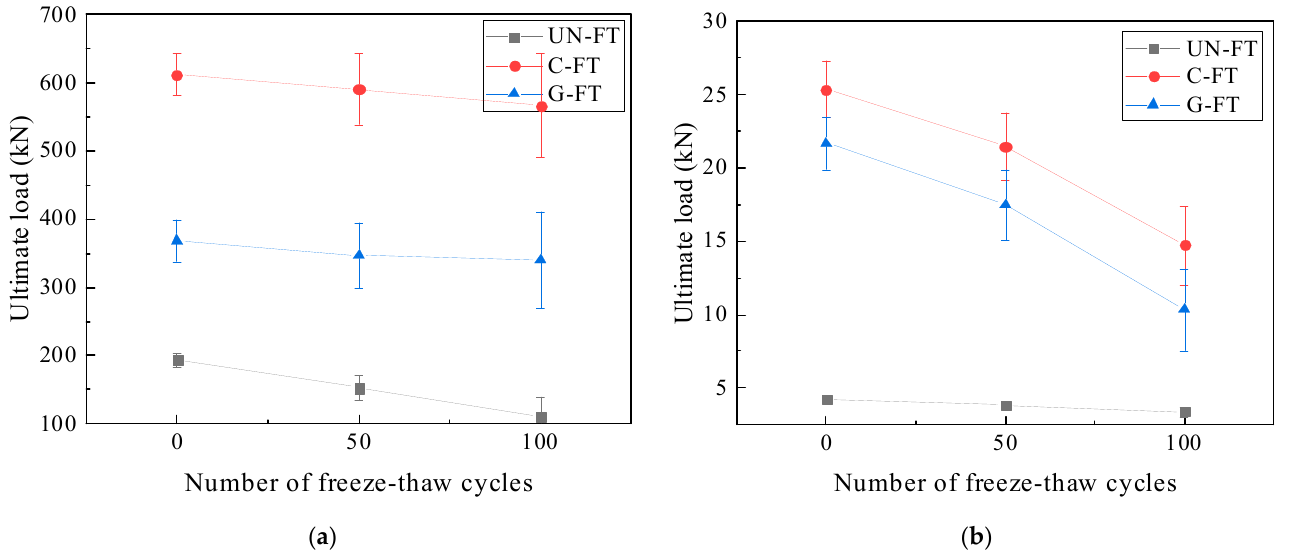
Figure 8. Axial pressure and bending load variation: ( a ) the relationship between axial pressure and the number of freeze–thawing; ( b ) the relationship between bending load and the number of freeze–